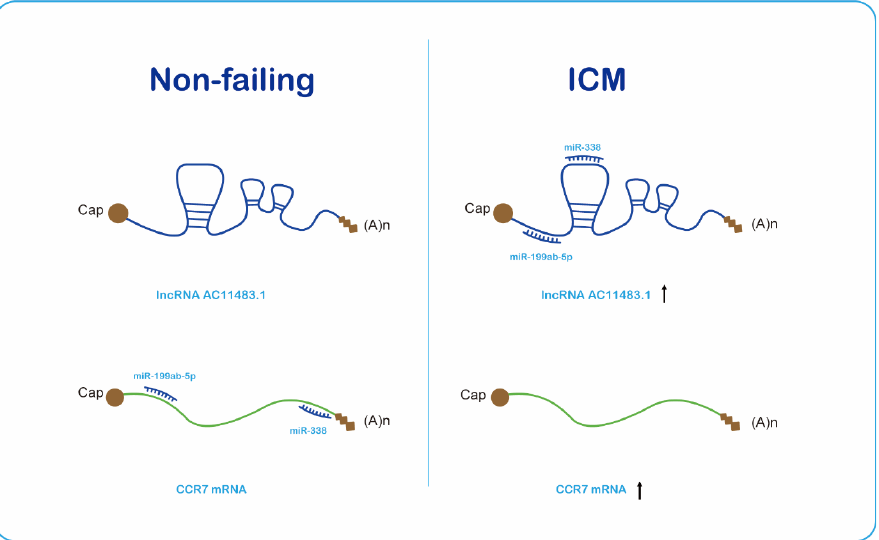
Figure 6. LncRNA AC011483.1 regulates mRNA CCR7 via miRNAs miR-199ab-5p and miR-338.